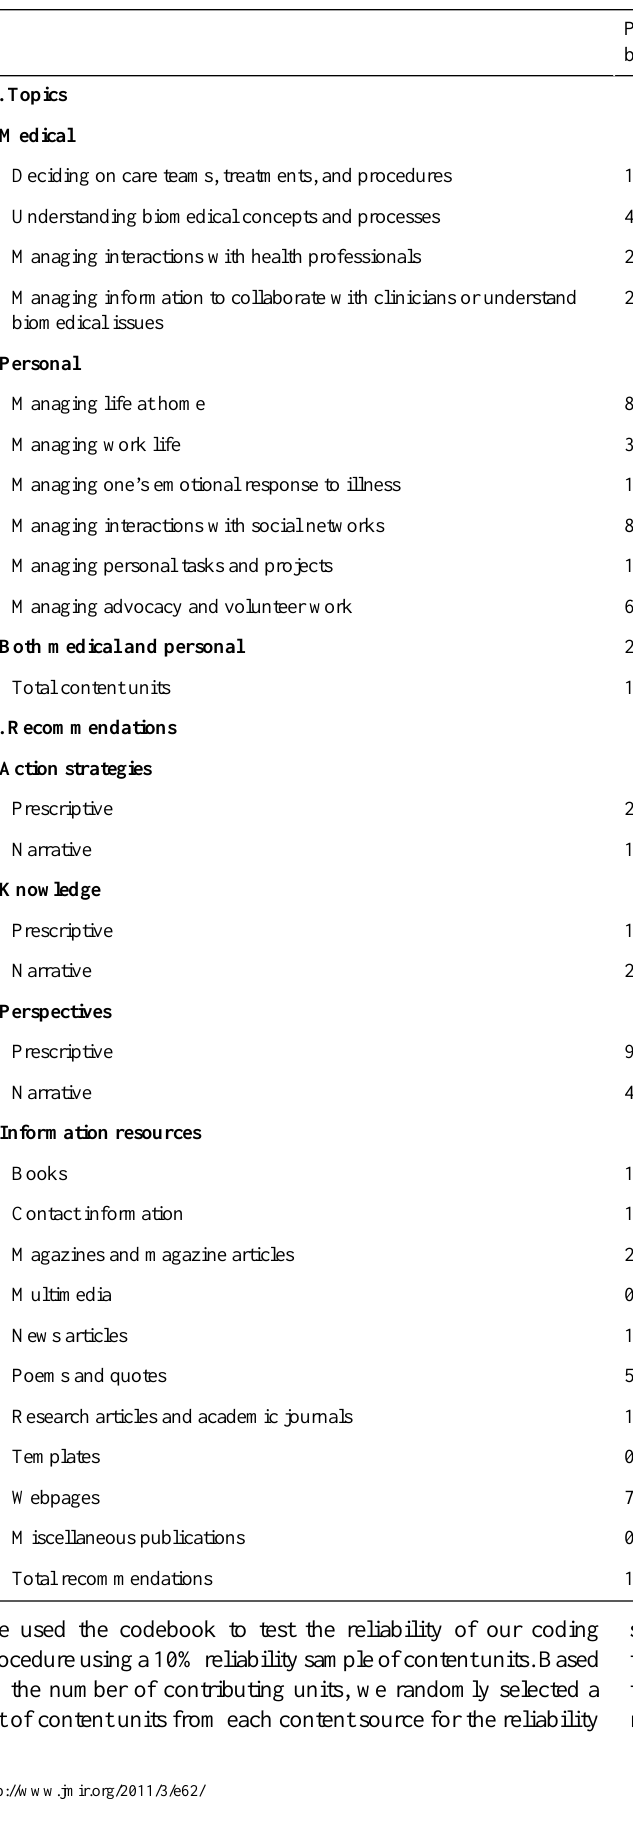
Table 3. Codebook of (a) topics and (b) recommendations (percentages reflect proportions of content units from each type of content